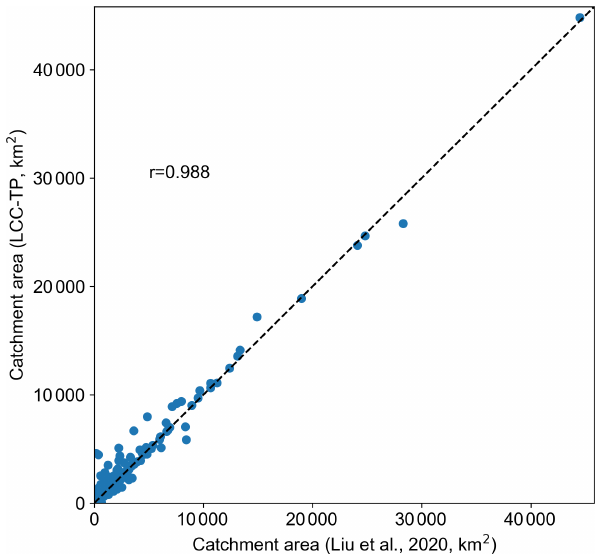
Figure 5. Comparison of the areas of delineated catchments in this study with those of Liu et al.